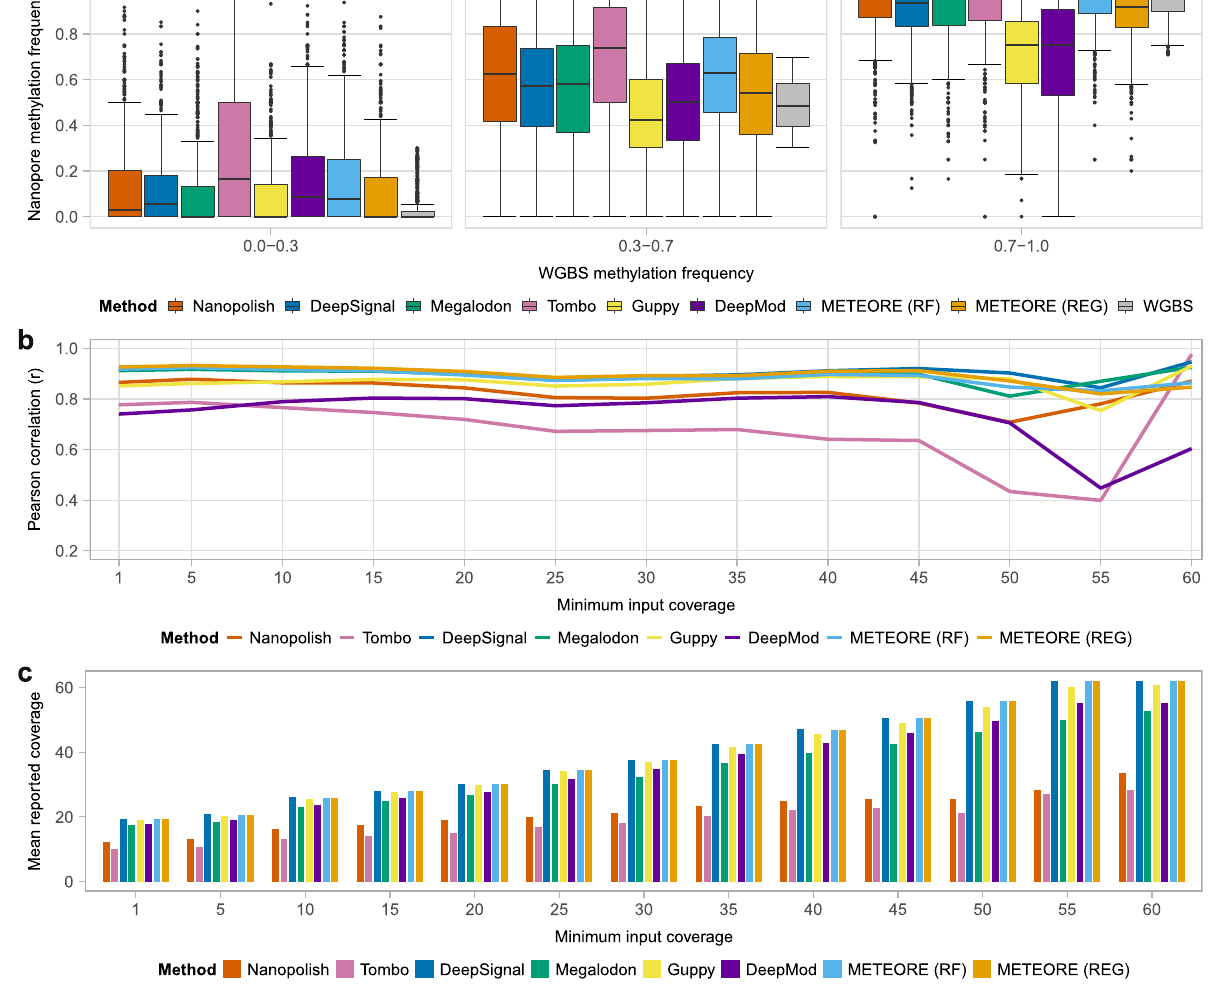
Fig. 4 Comparison of CpG methylation predictions from nanopore with whole-genome bisul fi te sequencing (WGBS). a Distribution of methylation calls ( n = 1743) from nanopore ( y axis) across three WGBS methylation bins: no or low methylation (0.0 – 0.3) ( n = 793), intermediate methylation (0.3 – 0.7) ( n = 264), and high or full methylation (0.7 – 1.0) ( n = 686). In the boxplots, the lower and upper boundaries of the box are the fi rst and third quartiles of the data, respectively, with the median indicated by a thick black line. The lower and upper whiskers extend to 1.5 times the interquartile range. The outliers are represented by the black dots. b Pearson ’ s correlation ( r ) ( y axis) between methylation frequencies calculated from nanopore reads and WGBS at sites by each of the tested tools (combining predictions from both strands) at each level of minimal input coverage, i.e., minimum number of nanopore reads considered per site as reported from the BAM fi le ( x axis). c Mean reported coverage (using the coverage reported by each tool for all sites) at each value of minimum input coverage in b . METEORE (RF) is the combination of Megalodon and DeepSignal using a random forest (parameters: max_depth = 3 and n_estimator = 10), and METEORE (REG) is the combination of Megalodon and DeepSignal using a regression